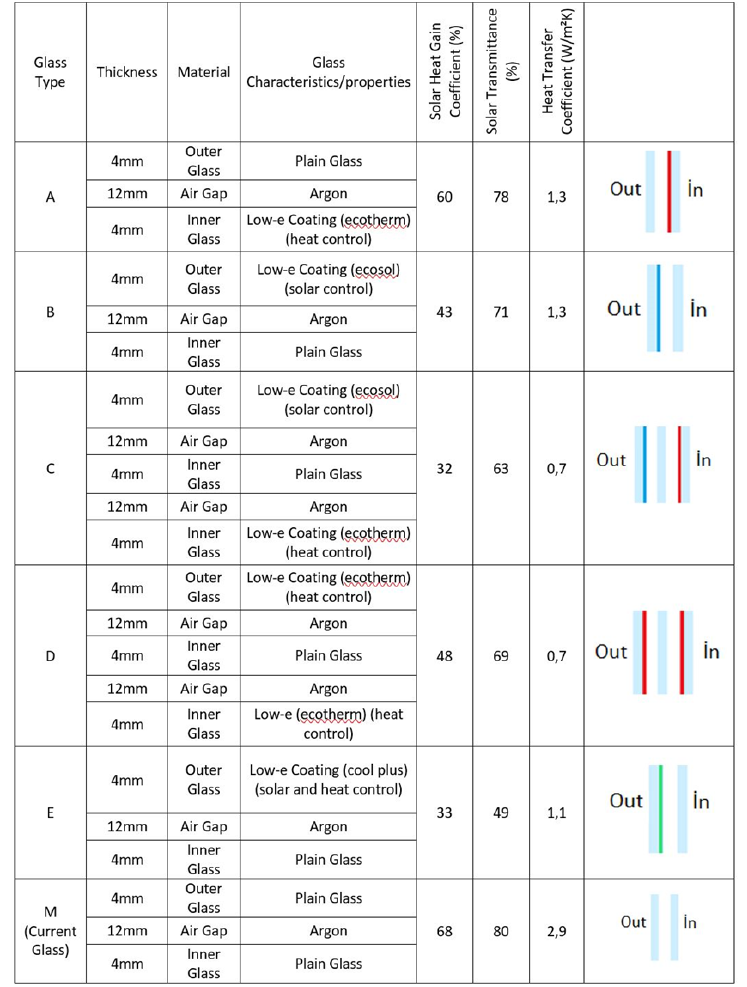
Table 4 Characteristics of glass types used in the model ( Low - e coating providing heat control, Low -e coating providing solar radiation control, Low - e coating providing solar radiation and heat control, Glass) (URL 4)